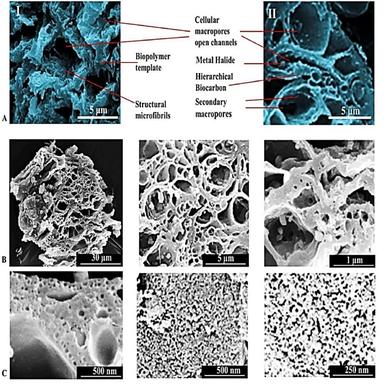
SEM micrographs of the multiscale porous structure and morphological characterization of the seaweed activated biocarbon indicating the conservation of the biomass cellular structure. A) Qualitative differences and morphological correlation between raw SW fibrous sample (I) compared to the biocarbon sample (II). B) Biocarbon macroporous template and its secondary networks. C) High-magnification SEM indicating the submicron and mesopore networks developed on the carbon surface layer.